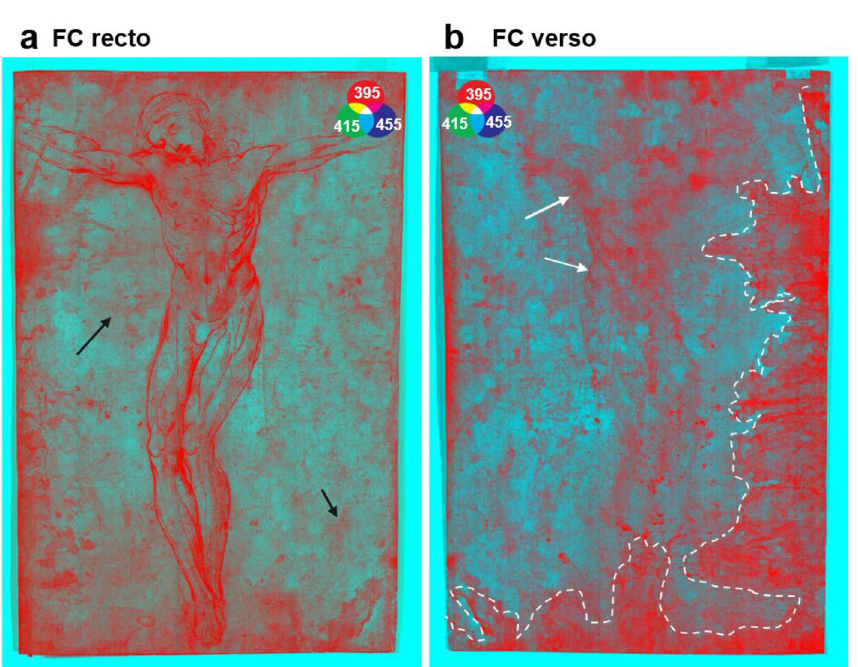
Figure 6. FC composite obtained with the images at 395 nm, 415 nm, and 455 nm, from the Vis–NIR scanner, of ( a ) the recto and ( b ) the verso of the drawing; the dashed areas highlight the zones where the liquid was accidentally spilled. The white arrows marked some areas where the iron-gall ink migrated from the recto to the verso; and the black arrows highlight some details not visible to the naked